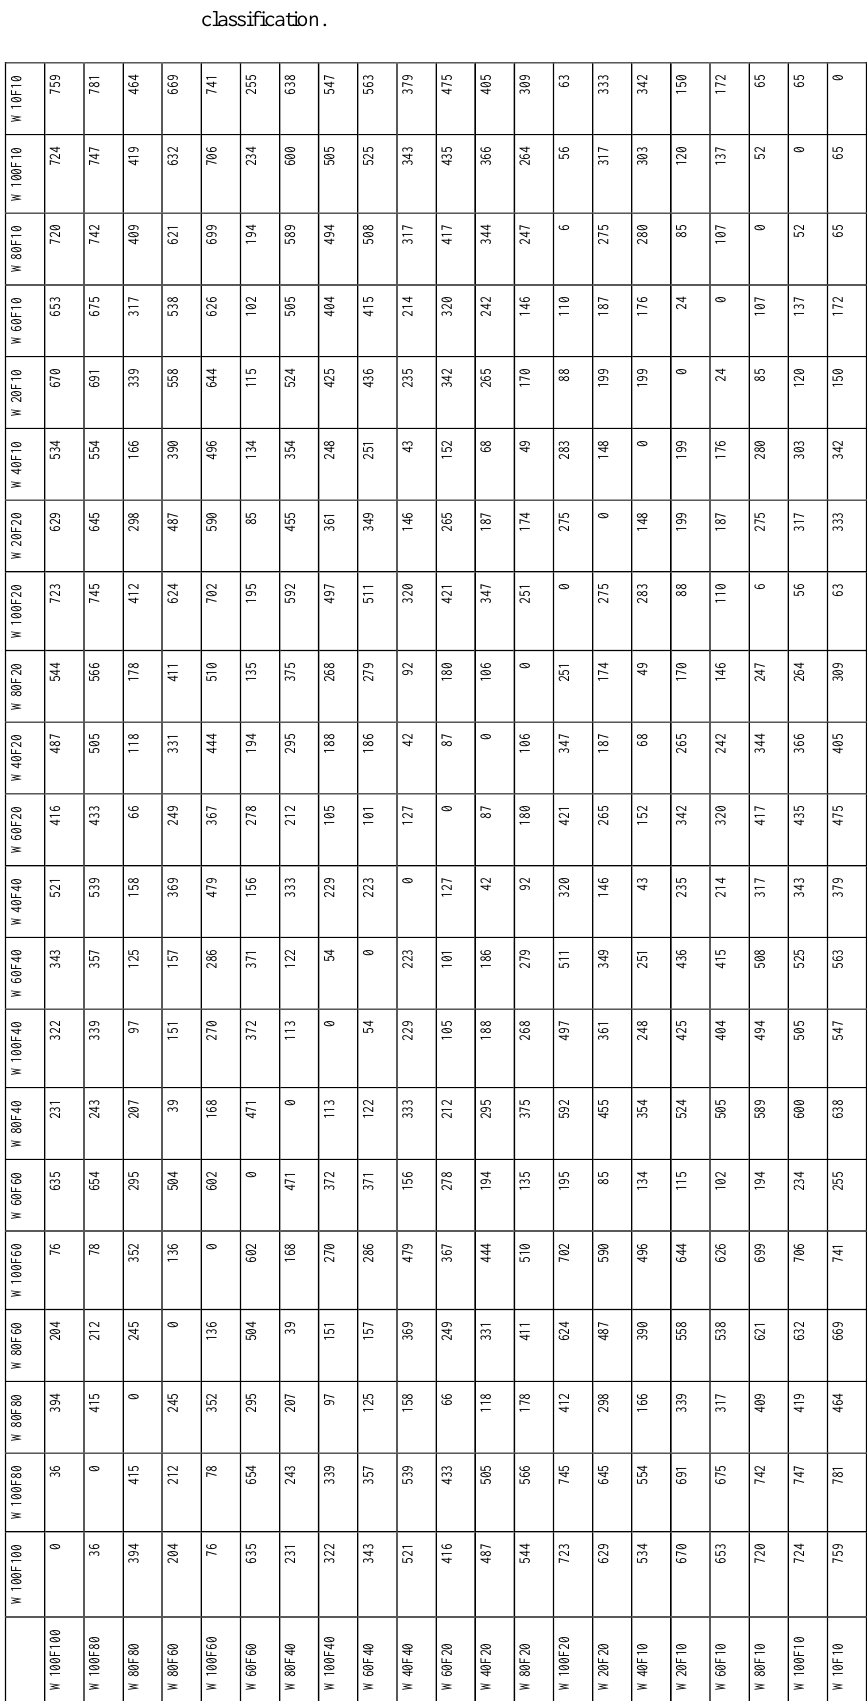
Table 4. JM distance matrix between the different forest classes from the SPOT data (simulating Sentinel-2 A and B)